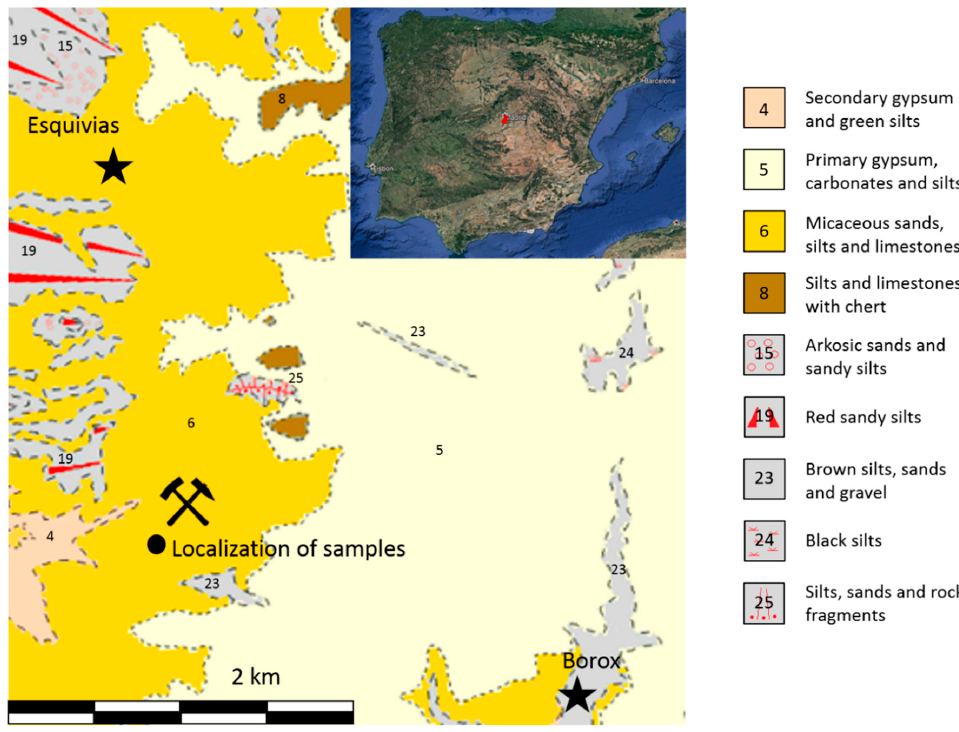
Figure 1. Geographical localization [28]. Universal Transverse Mercator (UTM) coordinates: 30T 434,662.31 m E 4,437,322.5 m N.